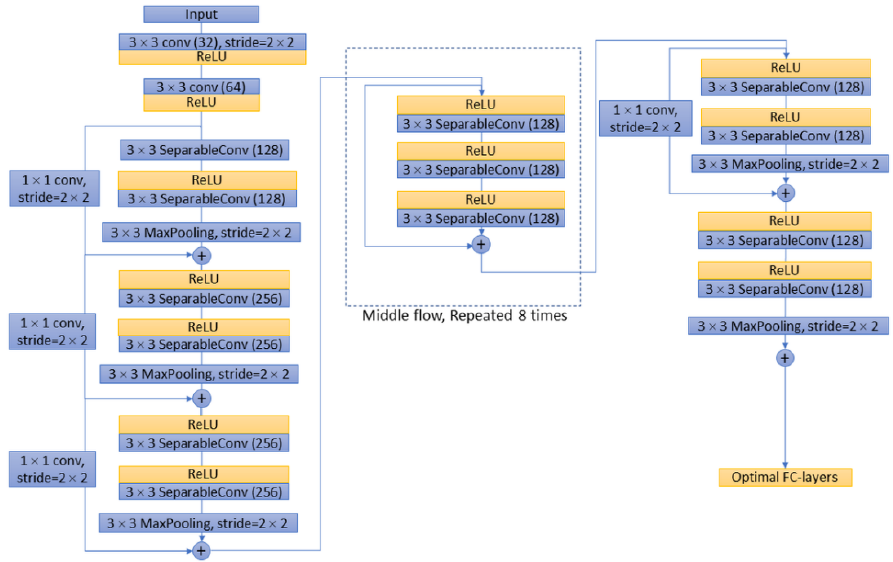
Figure 5. Network architecture of